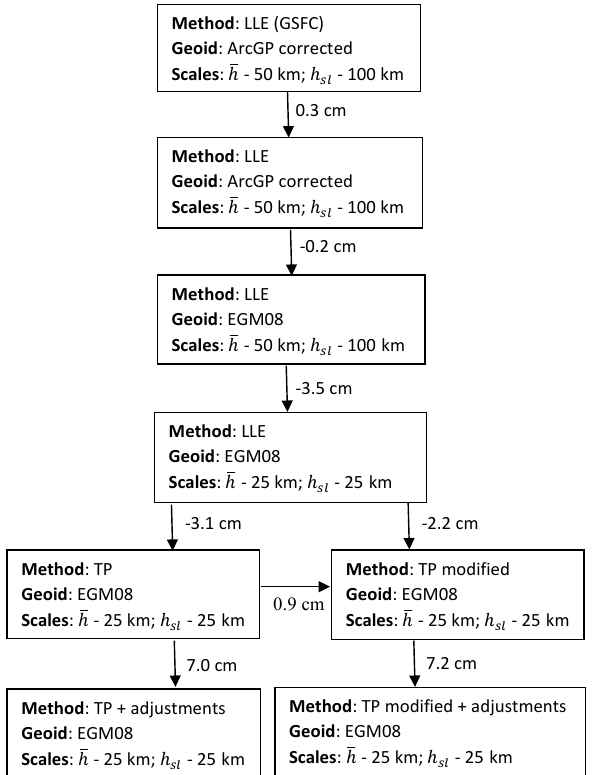
Figure 1. Flow chart of the methods, settings and geoids used for freeboard retrieval in our implementations of the TP and LLE meth- ods. Values next to the arrows are the mean differences between freeboard estimates as derived from Table 4.